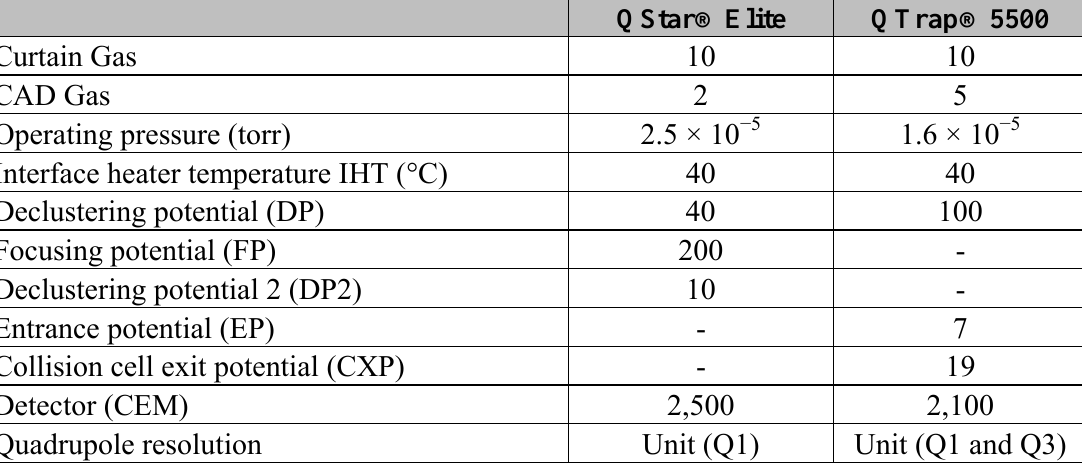
Table 2. Mass spectrometric settings used for lipid